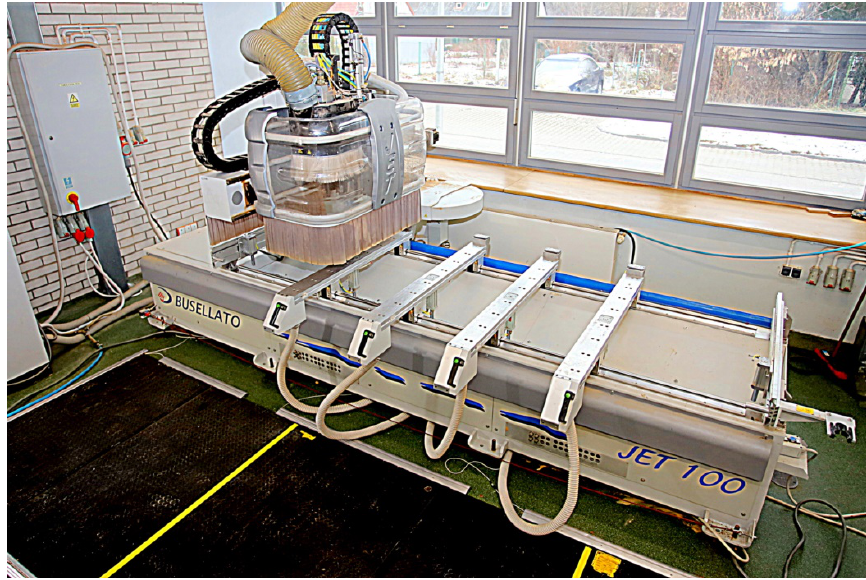
Figure 1. The standard CNC (computer numerical control) router (Busellato Jet 100), which was used during the experimental tests.